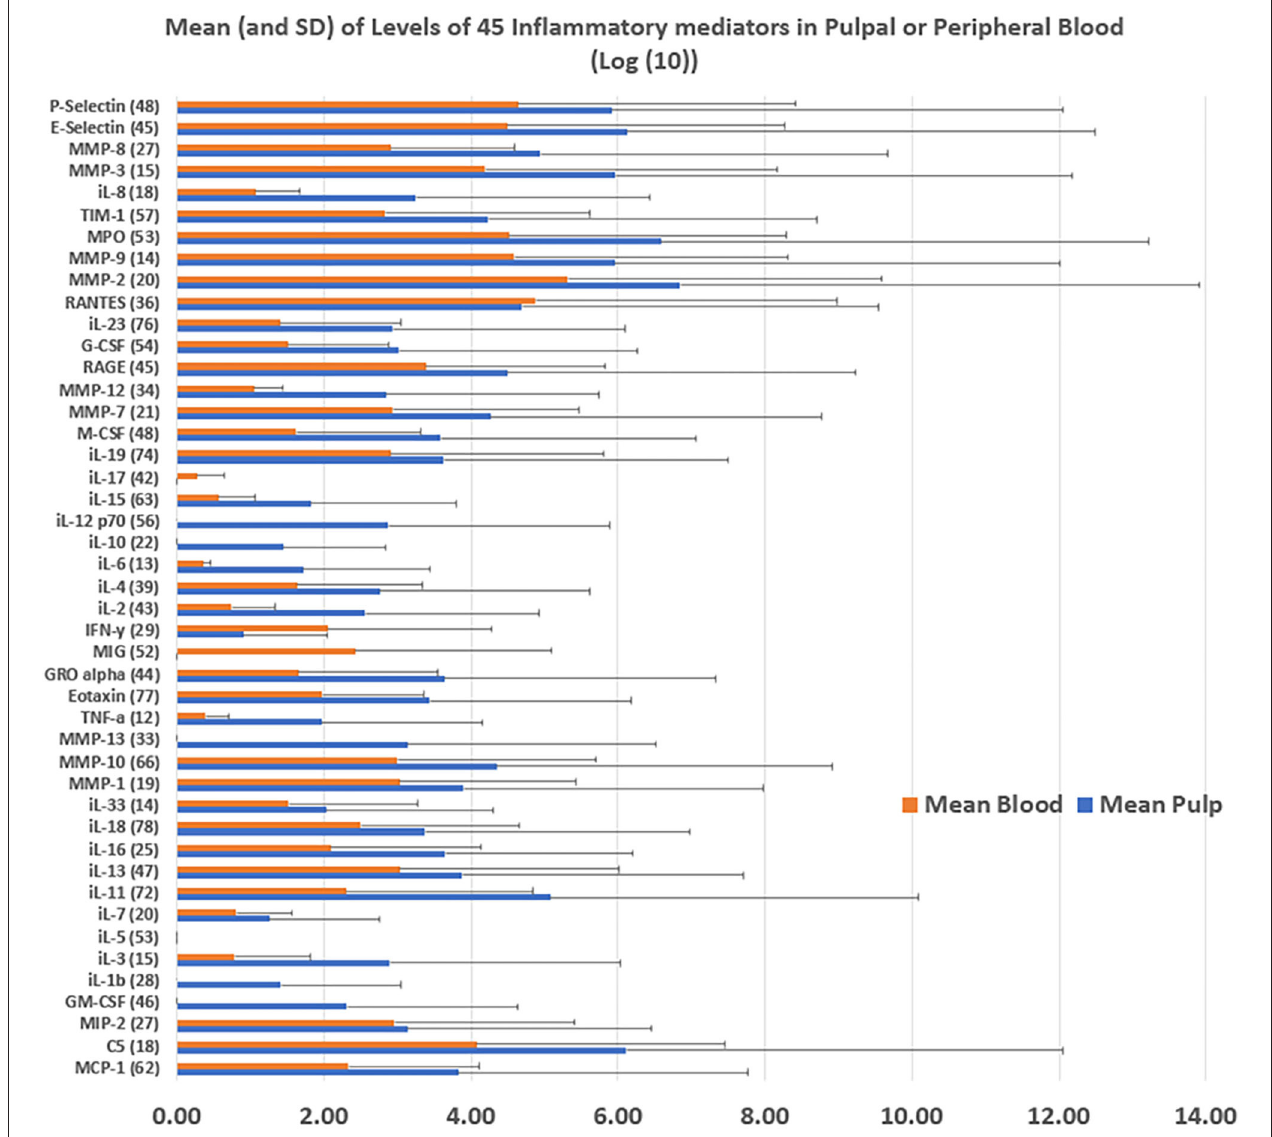
FIGURE 3 | Mean levels of 45 inflammatory proteins in pulpal or peripheral blood [Log (10)] were calculated from the average of expression levels from the collected pulpal and peripheral blood of three subjects enrolled in the study.